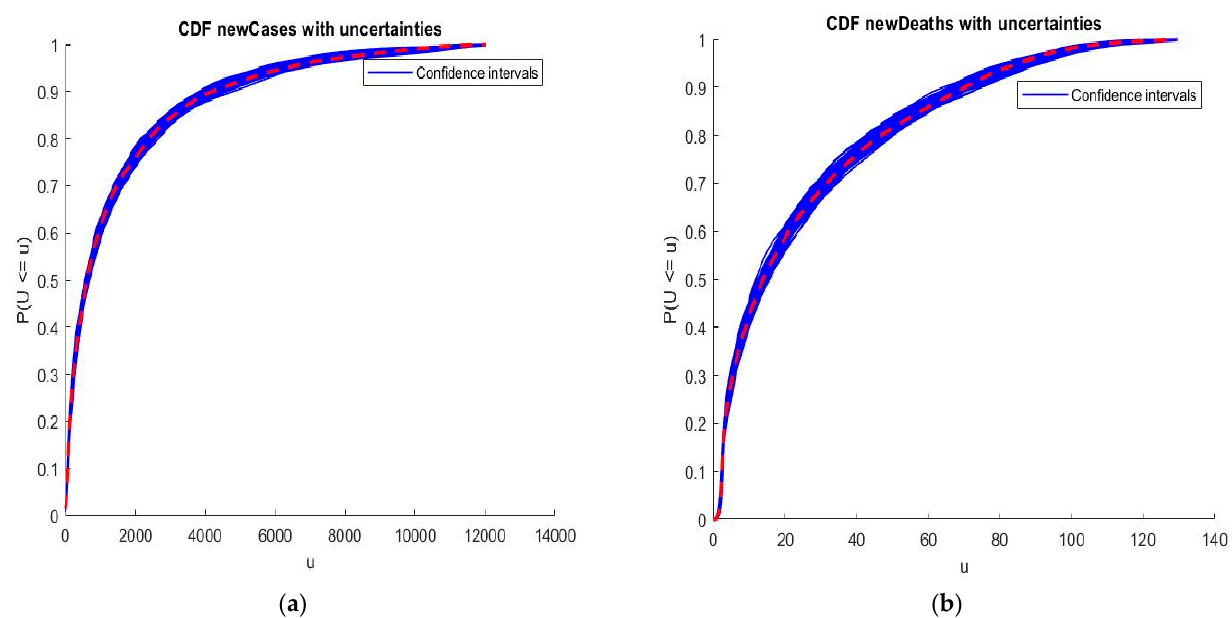
Figure 13. Estimation of the CDFs under uncertainties using Hausdorff distance: ( a ) CDF of infected individuals by SARS-CoV-2. ( b ) CDF of deaths by SARS-CoV-2. individuals by SARS-CoV-2. ( b ) CDF of deaths by